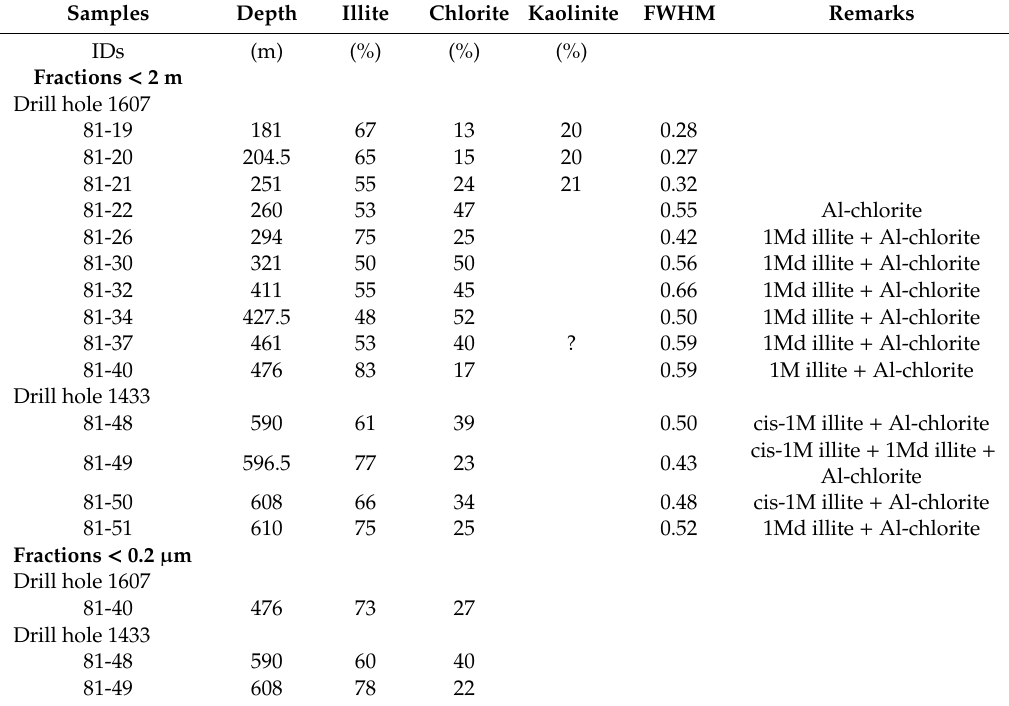
Table 1. X-ray data of the previously studied < 2 µ m by Philippe et al. [22] and of the < 0.2 µ m illite-rich size fractions analyzed